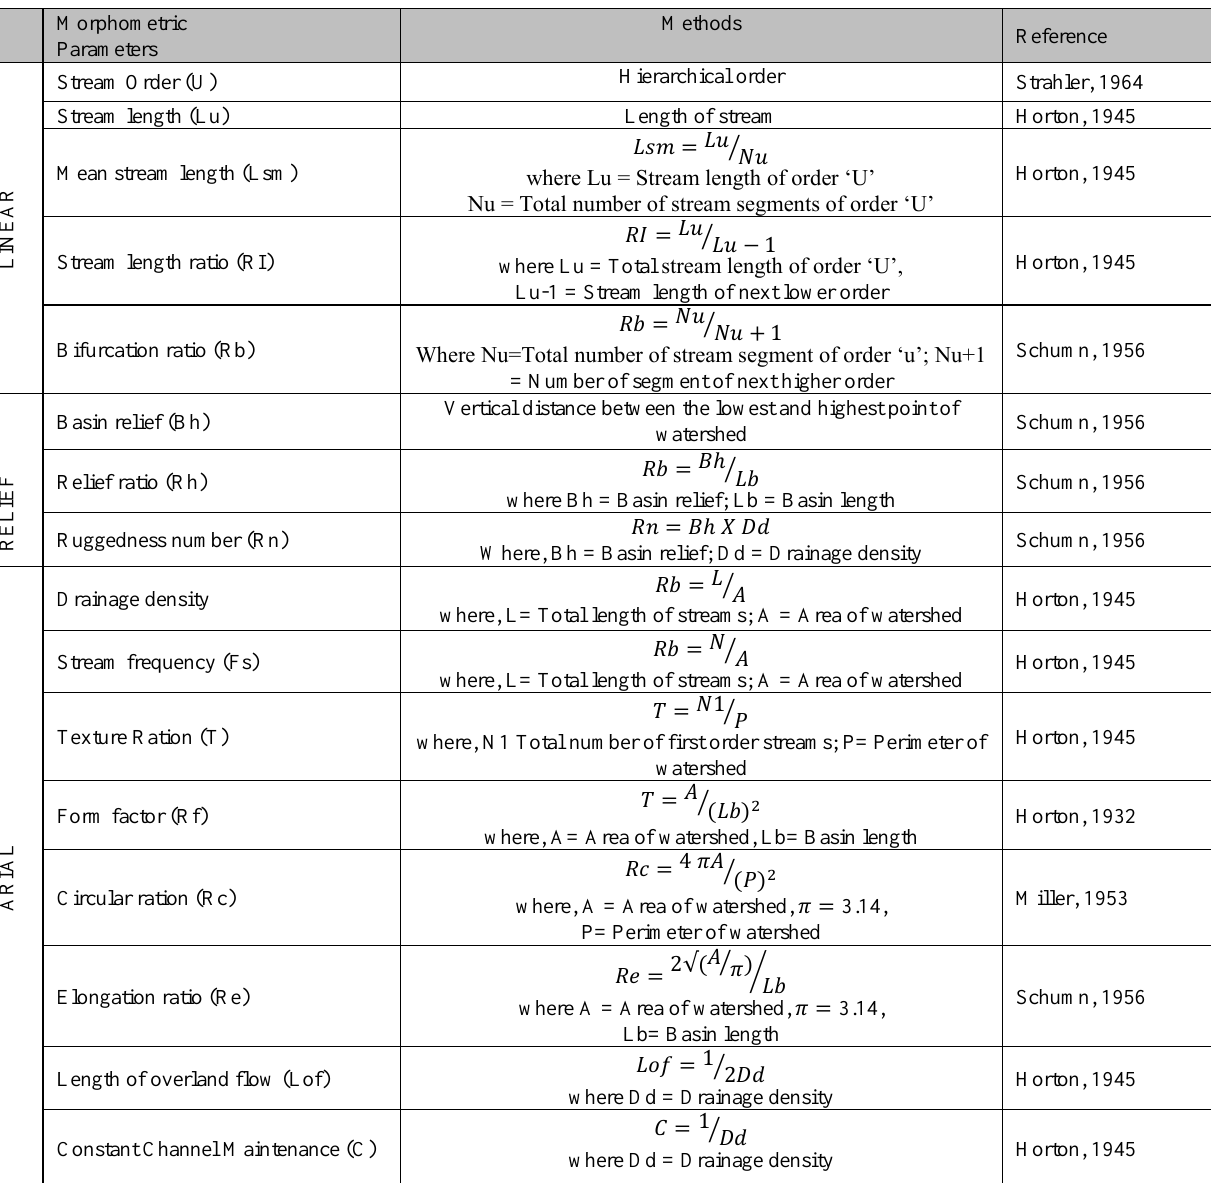
Table 1: Methods of Calculating morphometric parameters Source (Rekha et al,